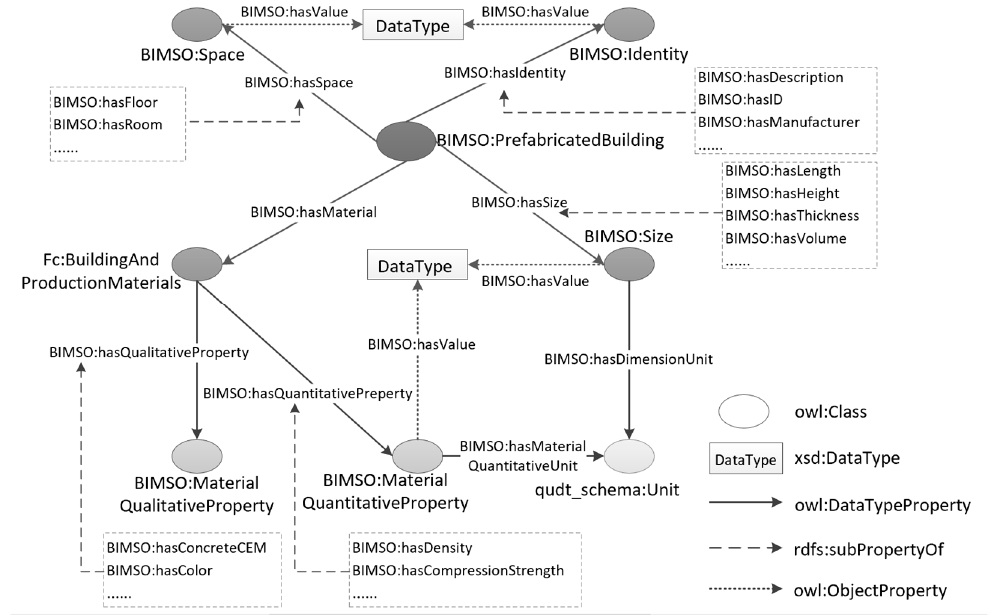
Figure 9. Conceptual diagram of BIM shared ontology.